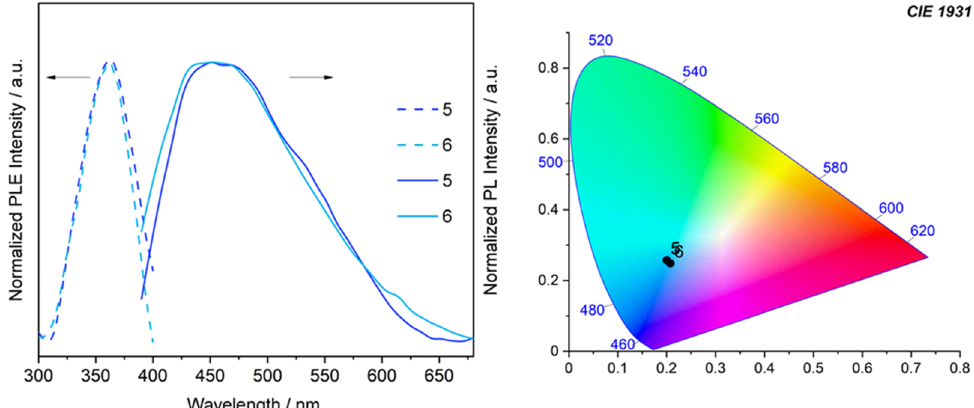
Figure 5. On the left, room temperature emission (solid line, λ exc 360 nm) and excitation (PLE, dashed line) spectra of complexes 5 and 6 in the solid state. On the right, a CIE 1931 chromaticity diagram for complexes 5 and 6 .